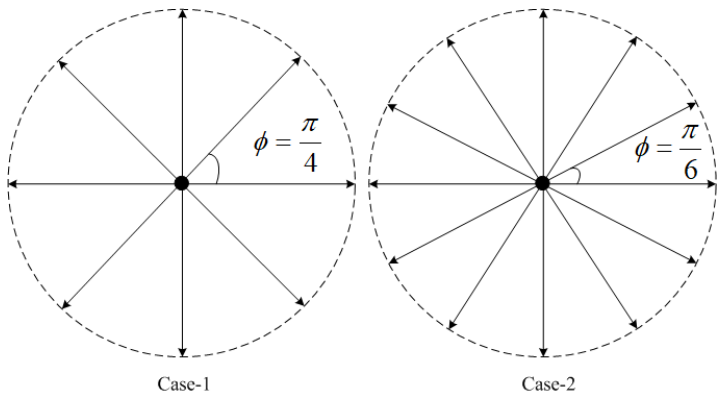
Figure 6. Simplified azimuth heading sets.